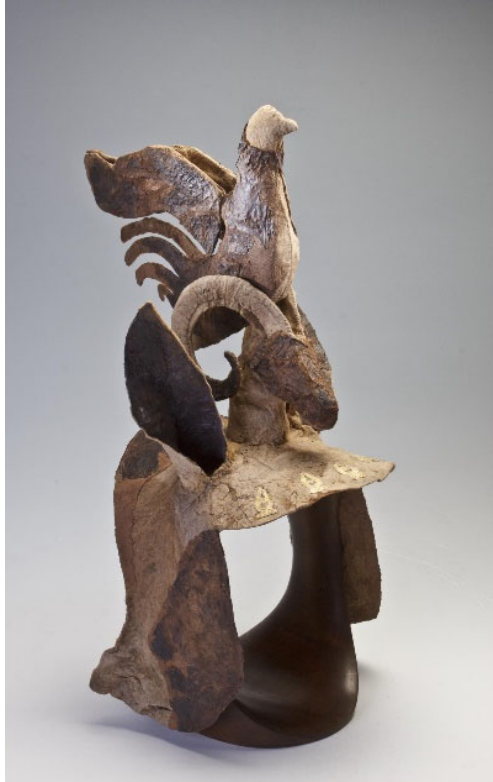
Figure 2. Horse headgear (SHM inv. no. 1684/414); felt, leather, wood, gold foil; Kurgan 2, Pazyryk, Altai mountains, Russia; late 4th to early 3rd century BC. [Image is used from